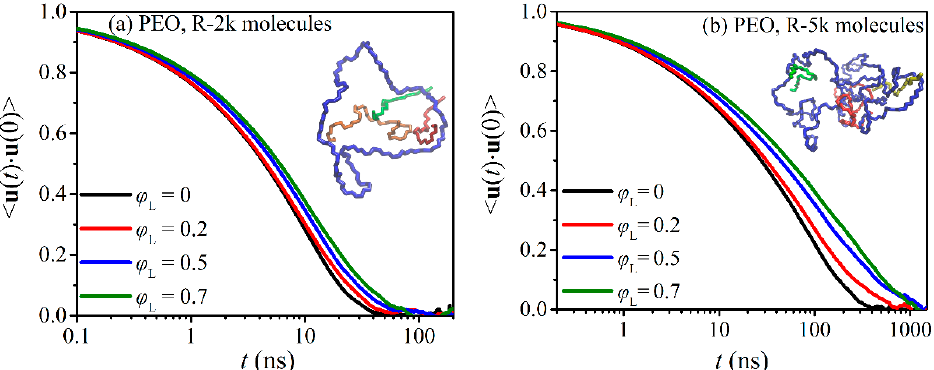
( ) ( ) ⋅ t 0 u u averaged over all ring molecules